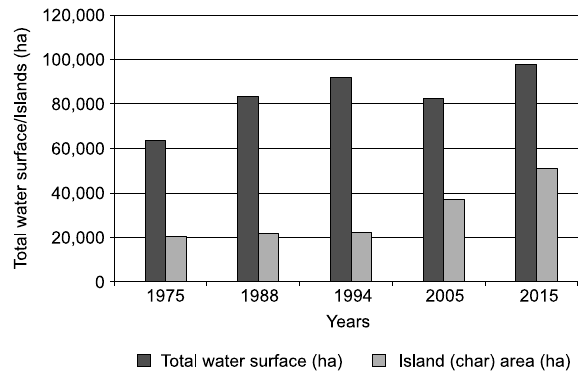
Fig. 4. Islands (char) area in Padma river in different